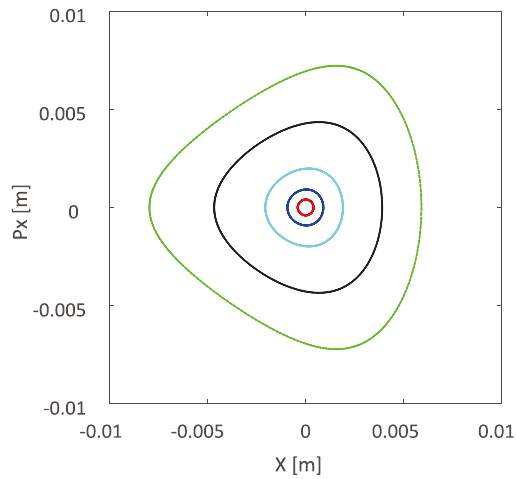
. Each FIG. 4. Tracking data points and fitted Hamiltonian tori in the x Þ horizontal